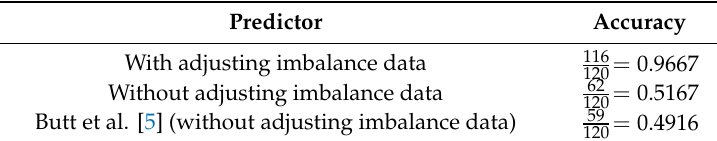
Table 2. Comparison results on the independent dataset 1.